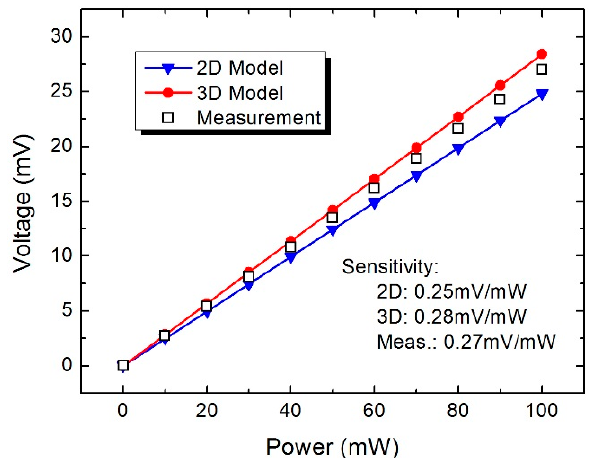
Figure 11. Measured voltage as a function of the incident power from 0 mW to 100 mW.